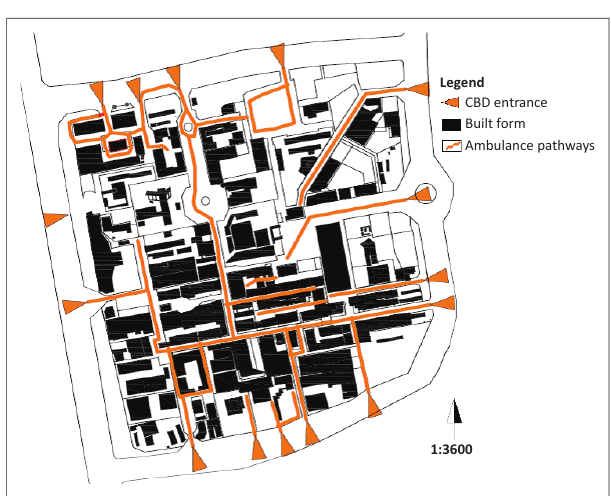
FIGURE 9: Ambulance pathways. CBD, central business district.